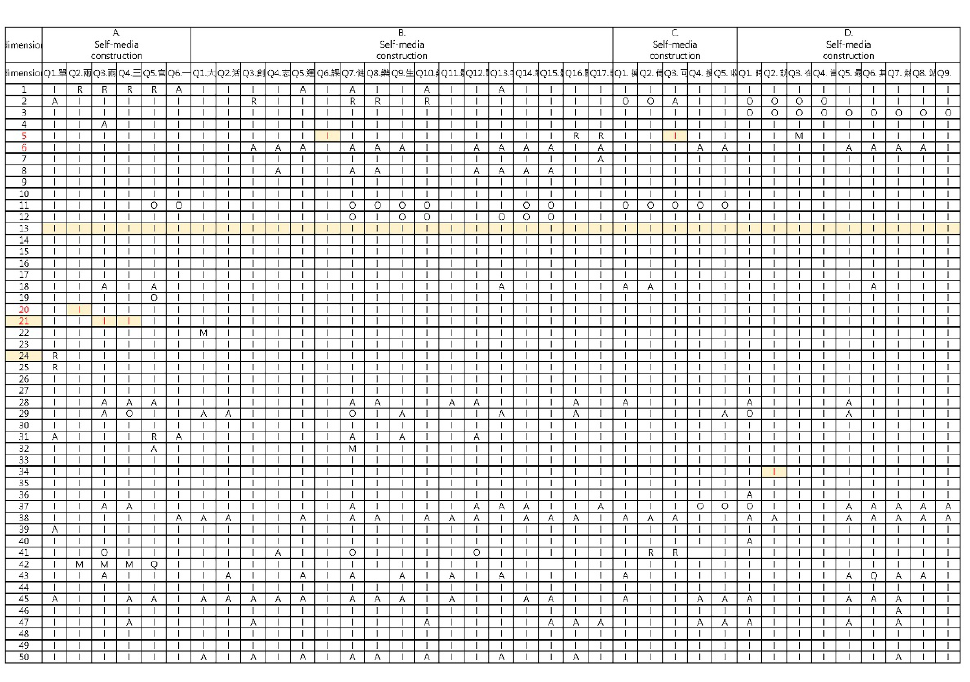
Figure 10. Kano model statistical process for self-media demand research.